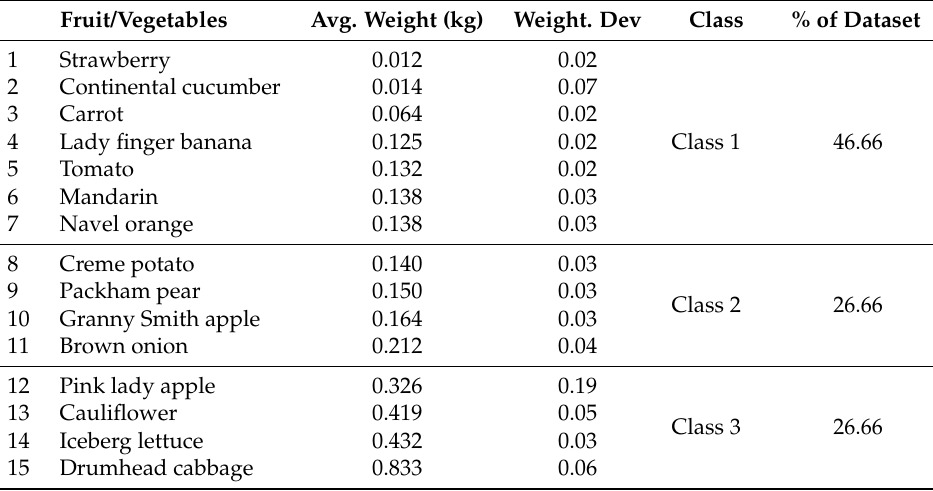
Table 5. Jenks Natural Break (JNB) based coarse classification of fruit and vegetables.